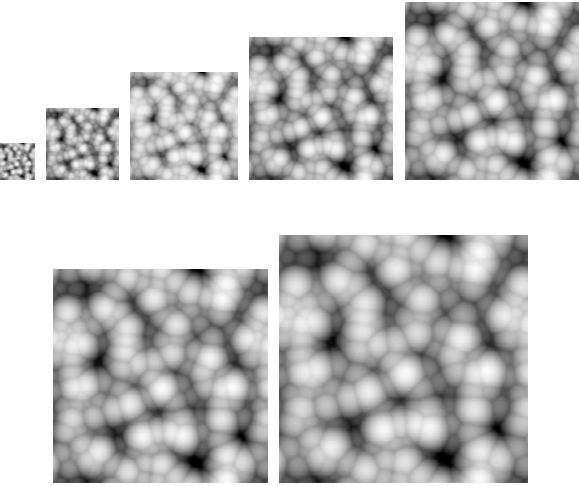
Figure 6. Seven different scales of the rectangle. (a) Size=50 pixels. (b) Size=100 pixels. (c) Size=150 pixels. (d) Size=200 pixels. (e) Size=250 pixels. (f) Size=300 pixels. (g) Size=350